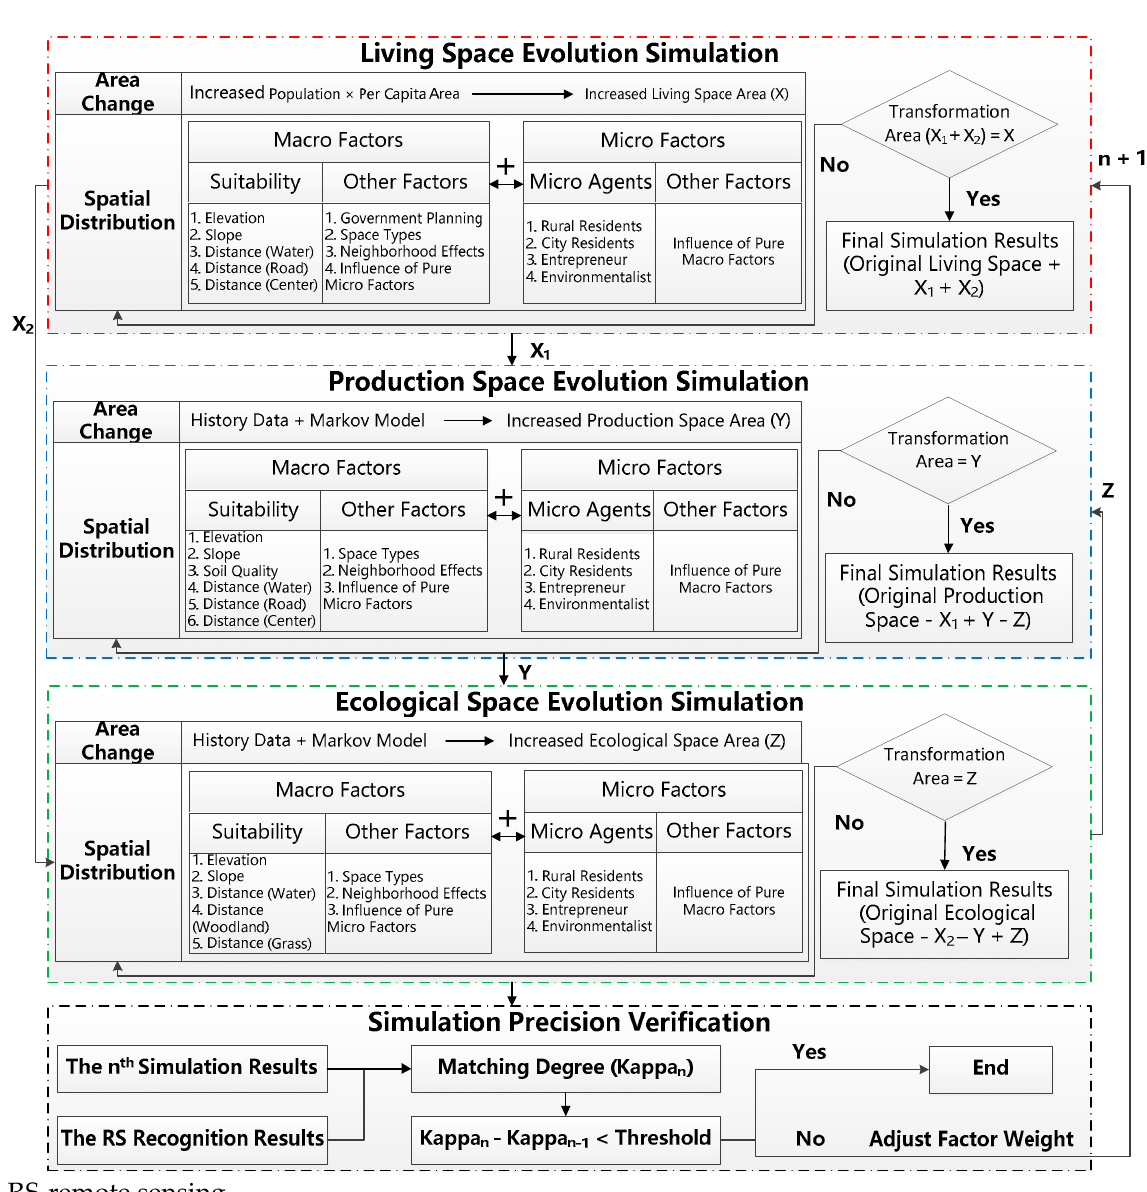
Figure 2. The data processing flow for simulating Production–Living–Ecological space evolution based on the macro and micro factor joint decision